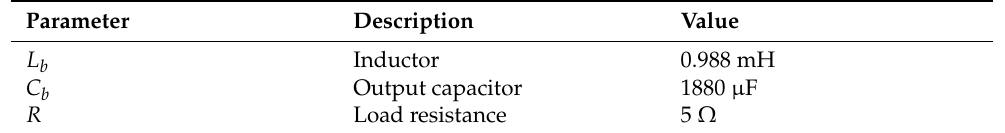
Table 2. Boost converter’s